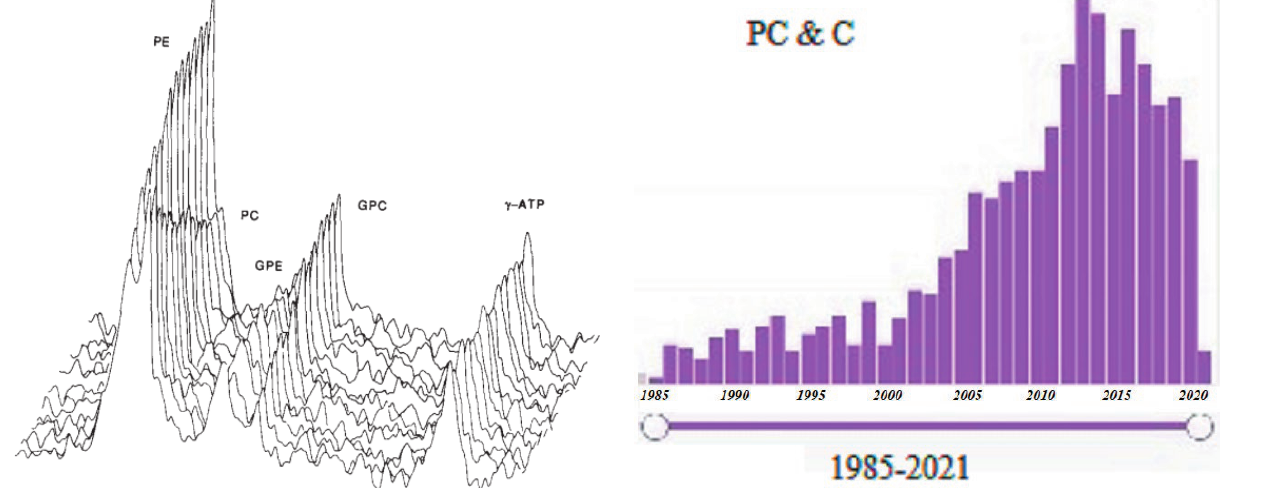
Figure 7. Effect of ethanolamine in the perfusate. Shown are quan- titative 31 P NMR spectra of cells grown in IMEM medium with 15 mM choline and no ethanolamine, harvested at log phase, and then perfused with Buffer A, 11 mM glucose, plus 2 mM ethanolamine at 37 o c. Each spectrum represents a l-hr accumulation. Hours 2 to 16 are shown. 13